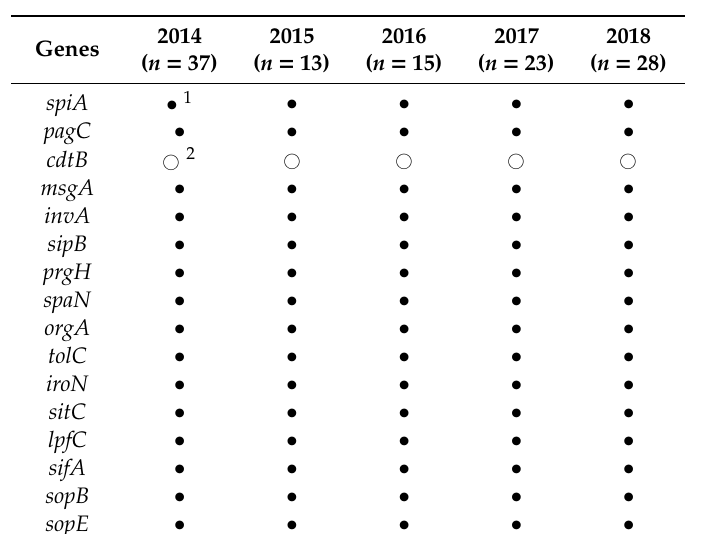
Table 2. Presence of virulence genes in 116 Salmonella Gallinarum